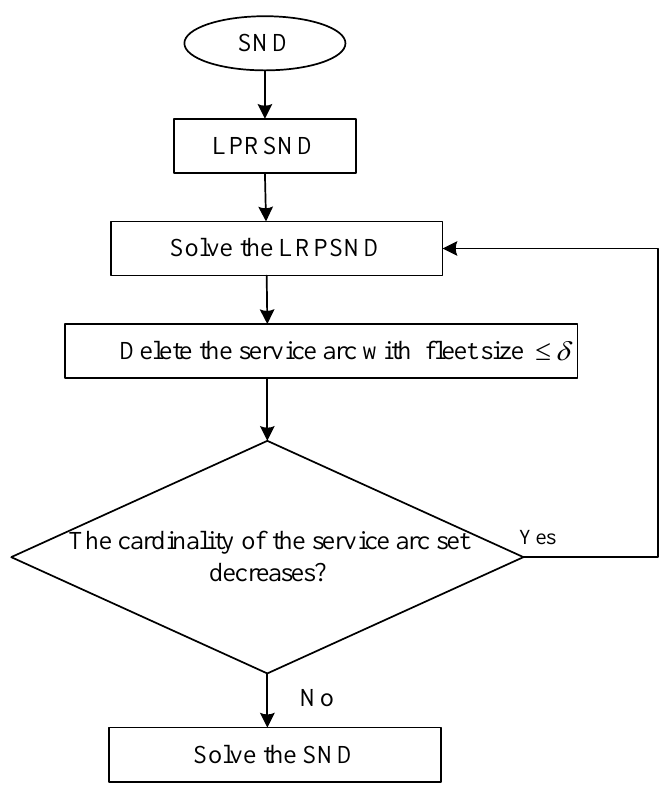
Figure 3. Flow chart of the